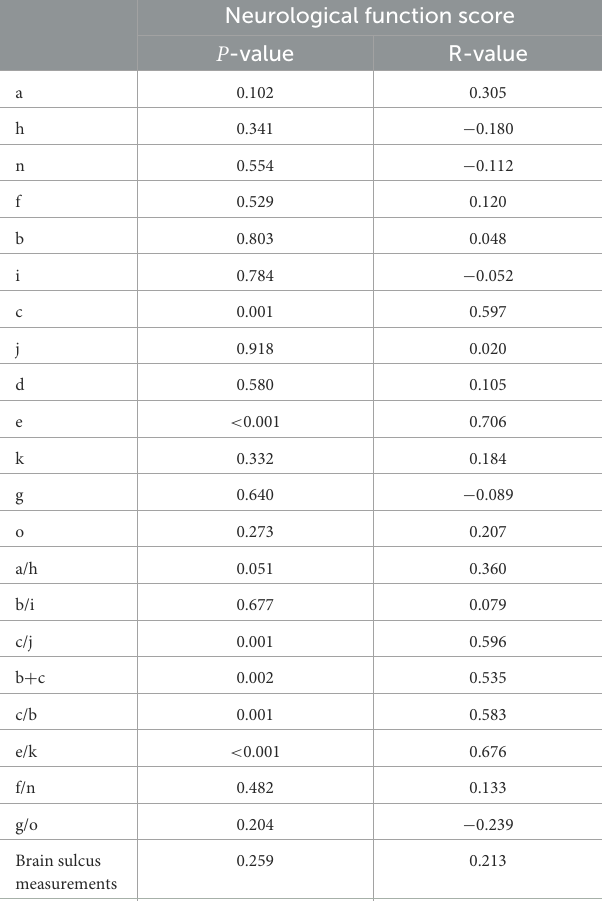
TABLE 4 Correlation between the UWDRS neurological function score and the linear measurement indicators of brain atrophy in WD patients. Neurological function